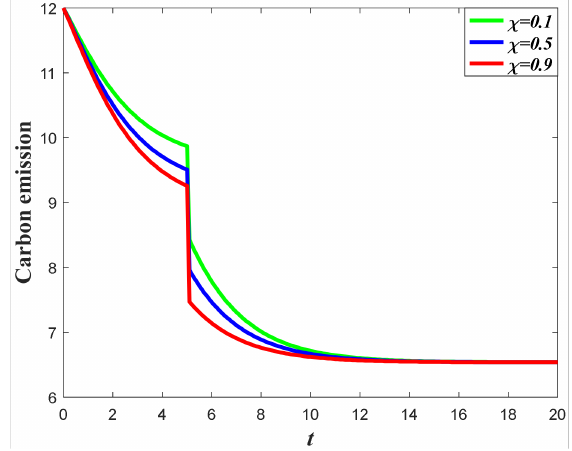
Figure 9. Impacts of χ on carbon emission when Ω 1 ≤ φ < Ω 2 .